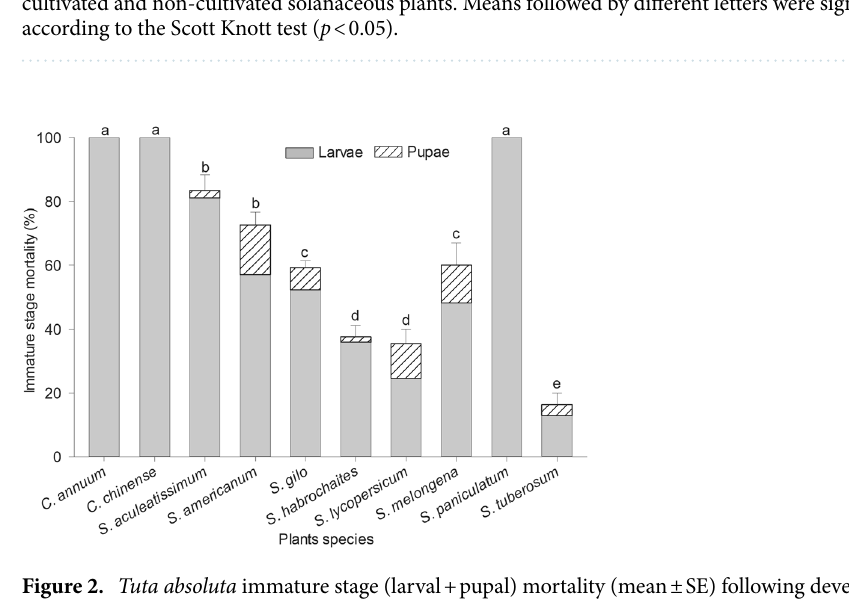
Figure 2. Tuta absoluta immature stage (larval + pupal) mortality (mean ± SE) following development on different solanaceous species. Means followed by different letters were significantly different according Scott Knott test ( p <